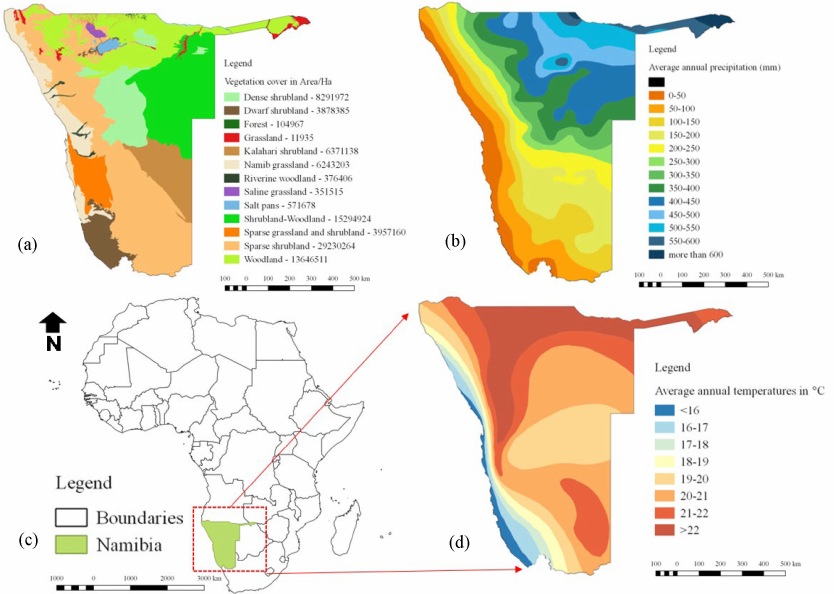
Figure 1. A map of the study area (Namibia) and key descriptions, ( a ) vegetation types, ( b ) precipita- tion variability, ( c ) the location of Namibia on the map of Africa, and ( d ) temperature